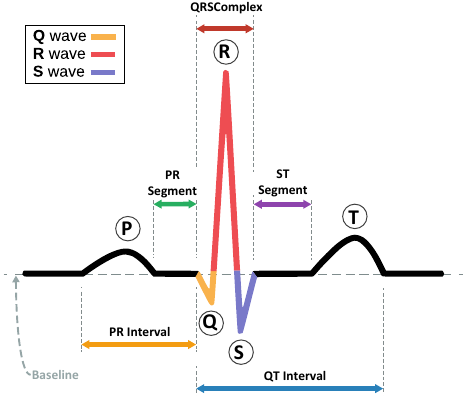
Figure 1. ECG of a heart in normal sinus